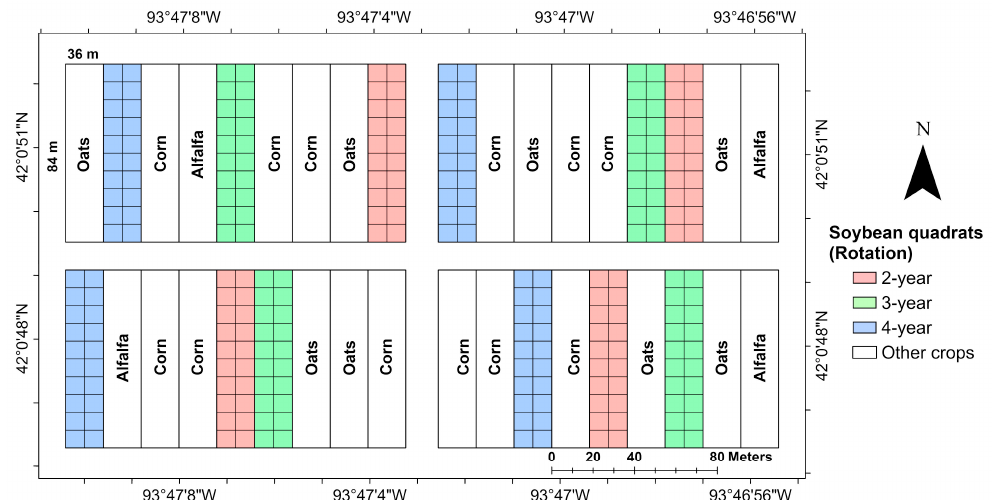
Figure 2. Overview of the Marsden Farm study site, located in Boone County, Iowa, in 2016. The randomized complete block design had four blocks with nine main plots, which were subdivided into two subplots. Subplots were divided into 10 quadrats (roughly 8 × 9 m, shown as grid squares). Main plots were planted with soybean in 2-year, 3-year, and 4-year crop rotations in 2016. Other plots were planted with corn, alfalfa, oat, and red clover. Soybean plot locations were prescribed by crop rotation sequences, which were assigned to main plots.